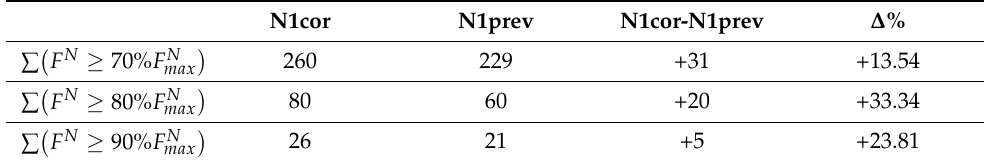
Table 5. Total number of EHV branches exploited close to the limit after optimization.